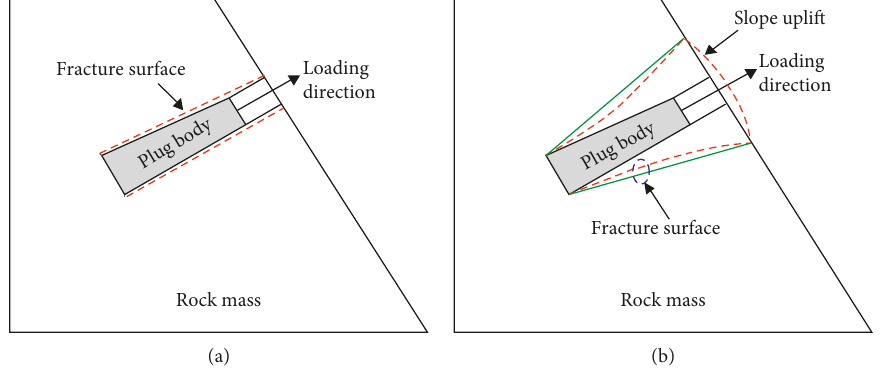
Figure 8: (a) Interface failure mode and (b) wedge failure